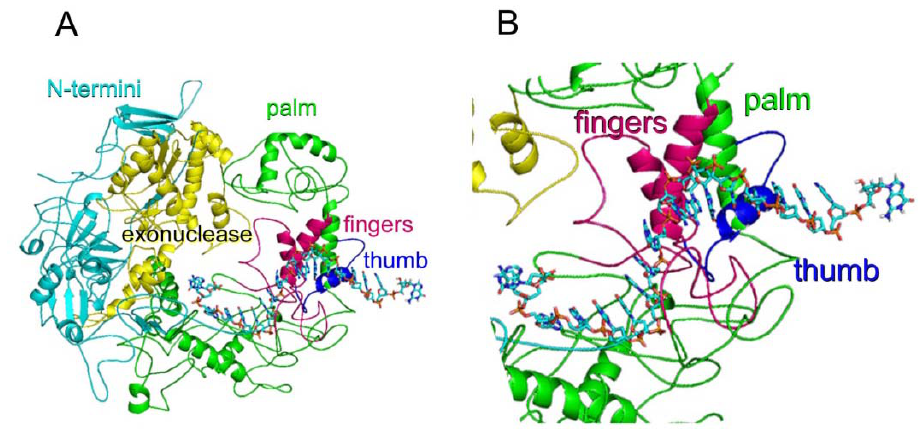
Figure 2. Molecular model of the core region of WSSV ORF514. (A) The sub domains were colored as follows: finger in magenta, thumbs in blue, palm in green. The domains were colored as follows: exonuclease in yellow, N-termini in cyan; (B) Close up to the active site where the fingers, palm and thumb are